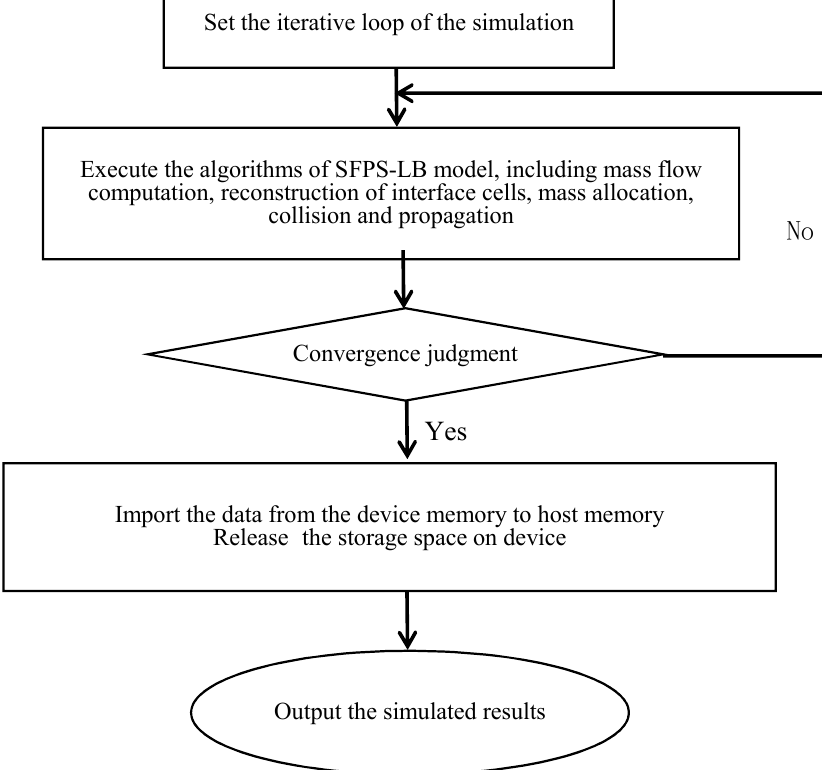
Figure A1. Parallel program of the SPFS-LB model based on Compute Unified Device Architecture